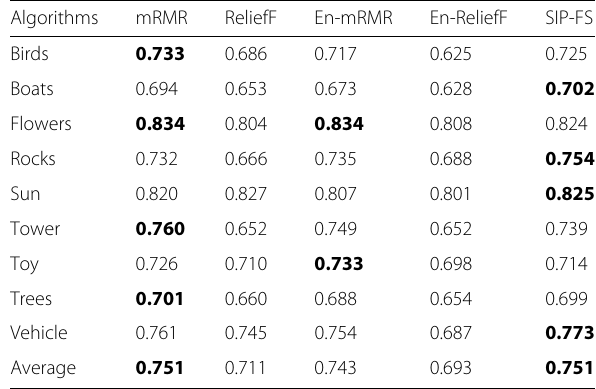
ratio, which are normalized by the respective maximum contribution